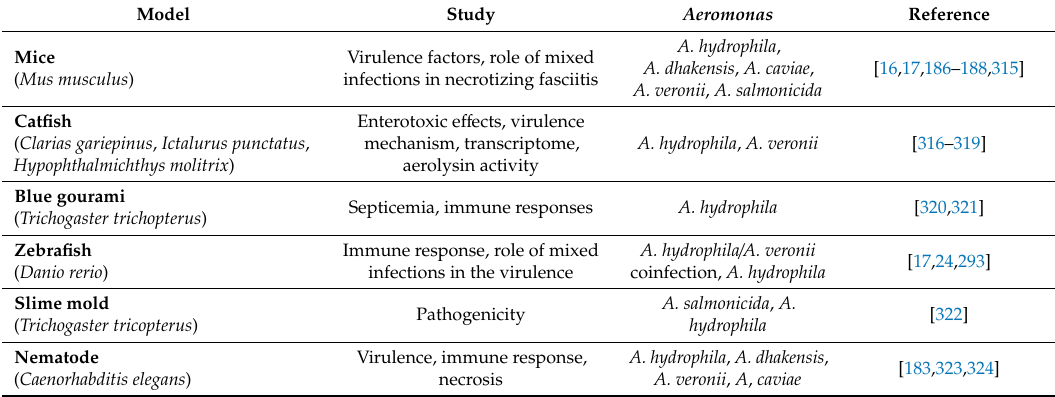
Table 4. Relevant studies (2000–2001) of virulence and pathogenicity after Aeromonas infection using di ff erent animal models (adapted from